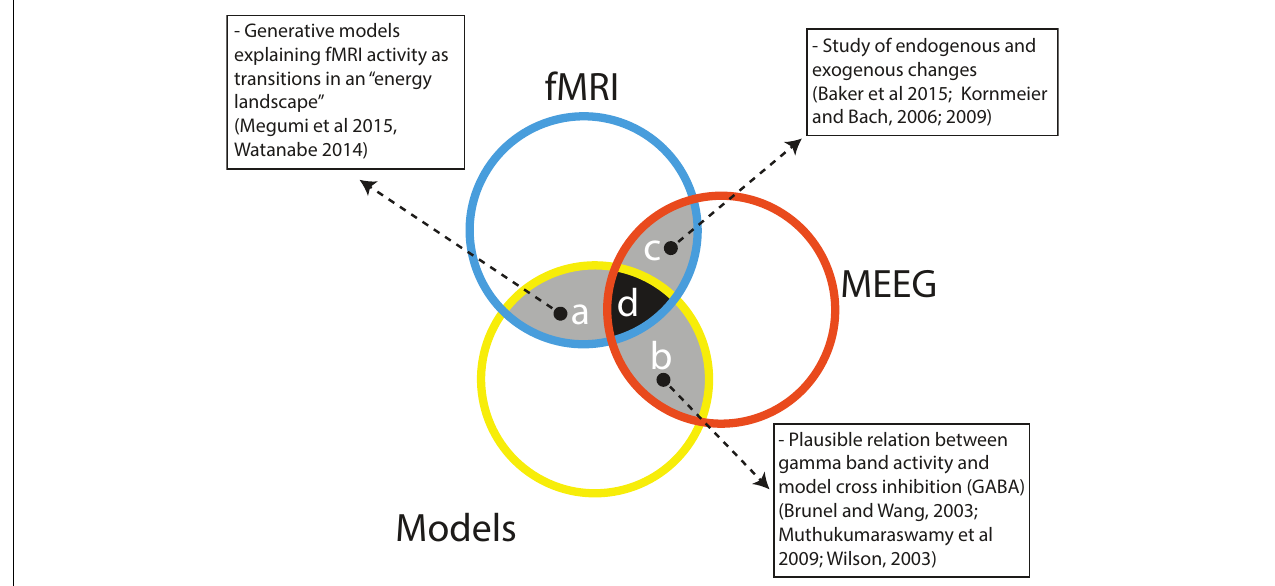
FIGURE 4 | Scarce integration between the techniques currently used to study bi-stable perception. References: Megumi et al. (2015); Watanabe et al. (2014); Baker et al. (2015); Kornmeier and Bach (2006, 2009); Brunel and Wang (2003); Muthukumaraswamy et al. (2009); Wilson (2003). to the modelized phenomenon. This is done by concentrating on a few biologically plausible parameters while disregarding all the remaining biological processes pertaining to multi- stable